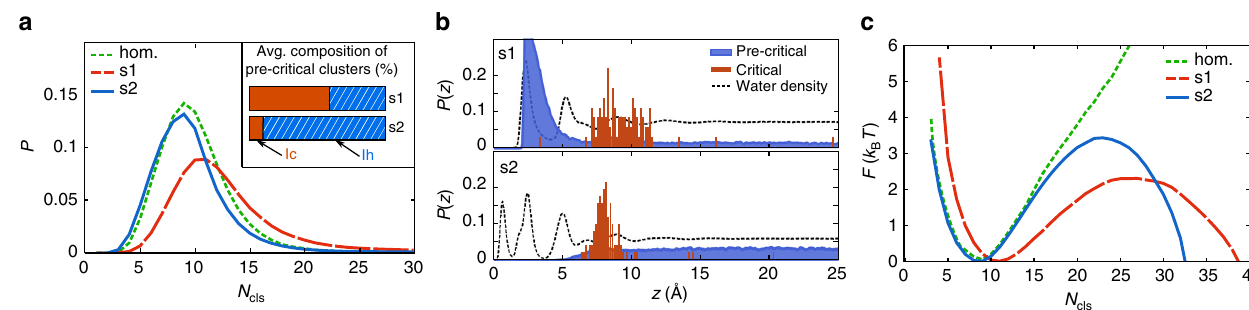
Fig. 2 Cluster formation and free energy of ice formation for the two substrates at 218 K. a Probability distribution of the size of the biggest ice-like cluster N cls . The inset shows the average composition of precritical clusters within 5 Å of the surface. b Probability distribution (blue) for the center of mass of ~100,000 precritical clusters. Positions of critical clusters are indicated in red. The water density is also indicated by dashed black lines (arbitrary scale). c Free energy pro fi les as a function of N